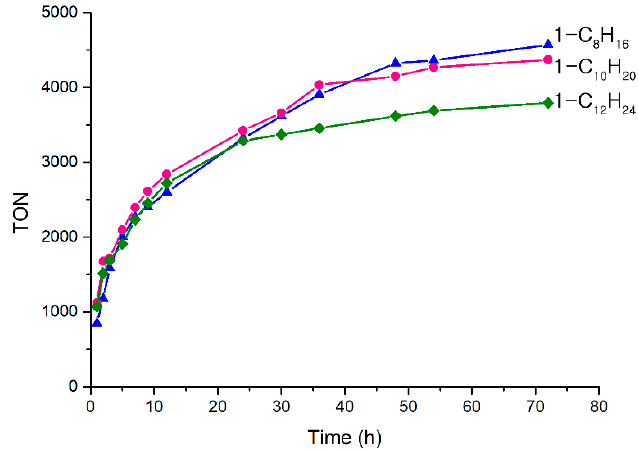
Figure 4. Turnover number (TON) vs. time for various monomers.